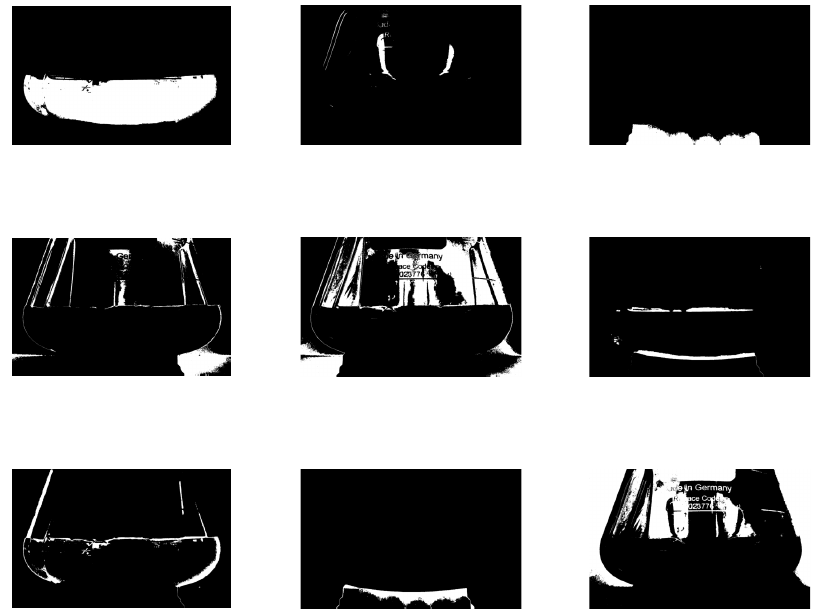
Figure 4. Result of applying K-means clustering to an